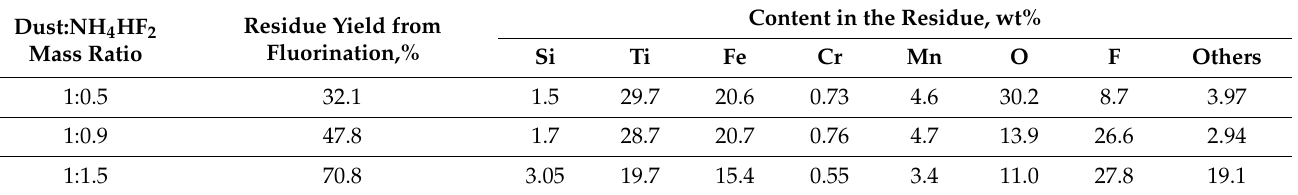
Table 4. Results of fluorination of electric melting dust of ilmenite concentrate. Influence of dust:NH 4 HF 2 mass ratio.